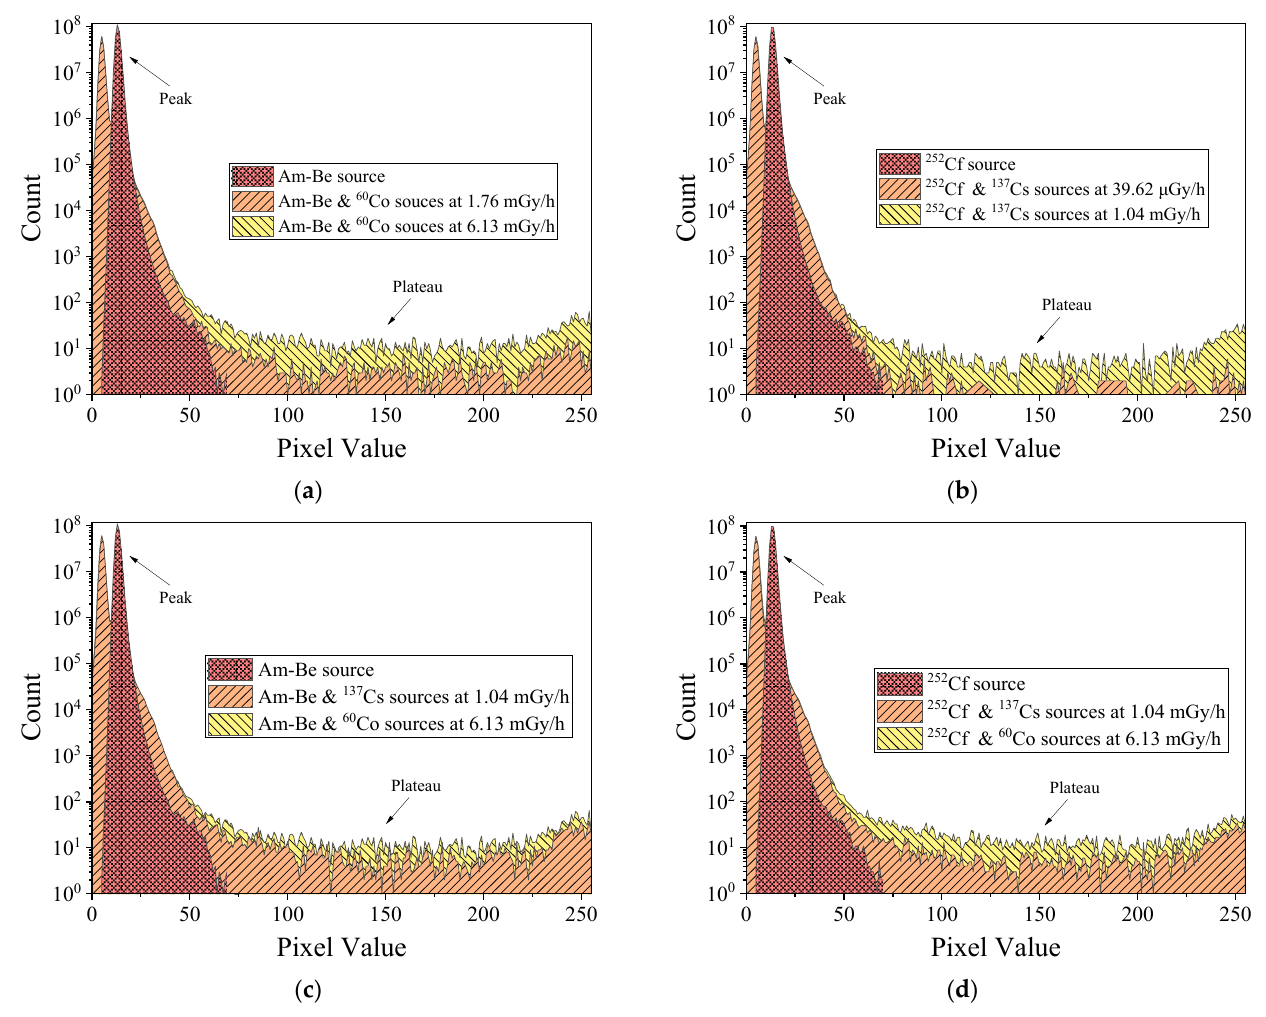
Figure 8. Histograms of mixed radiation signals of sensor. ( a ) Am-Be and 60 Co sources. ( b ) 252 Cf and 137 Cs sources. ( c ) Am-Be and 137 Cs or 60 Co sources. ( d ) 252 Cf and 137 Cs or 60 Co sources.